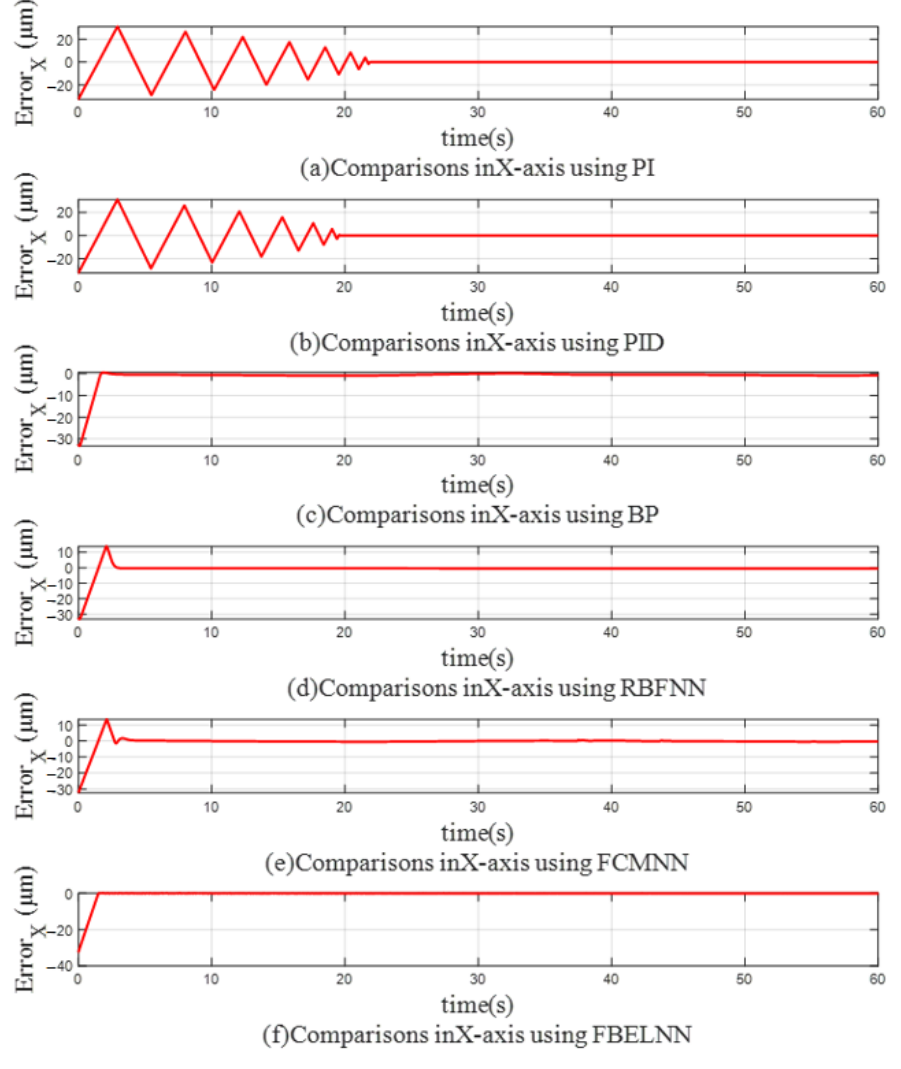
Figure 8. The trajectory error on the X -axis (single-cell manipulation): ( a ) Use PI as a controller. ( b ) Use PID as a controller. ( c ) Use BP as a controller. ( d ) Use RBFNN as a controller. ( e ) Use FCMNN as a controller. ( f ) Use FBELNN as a controller.